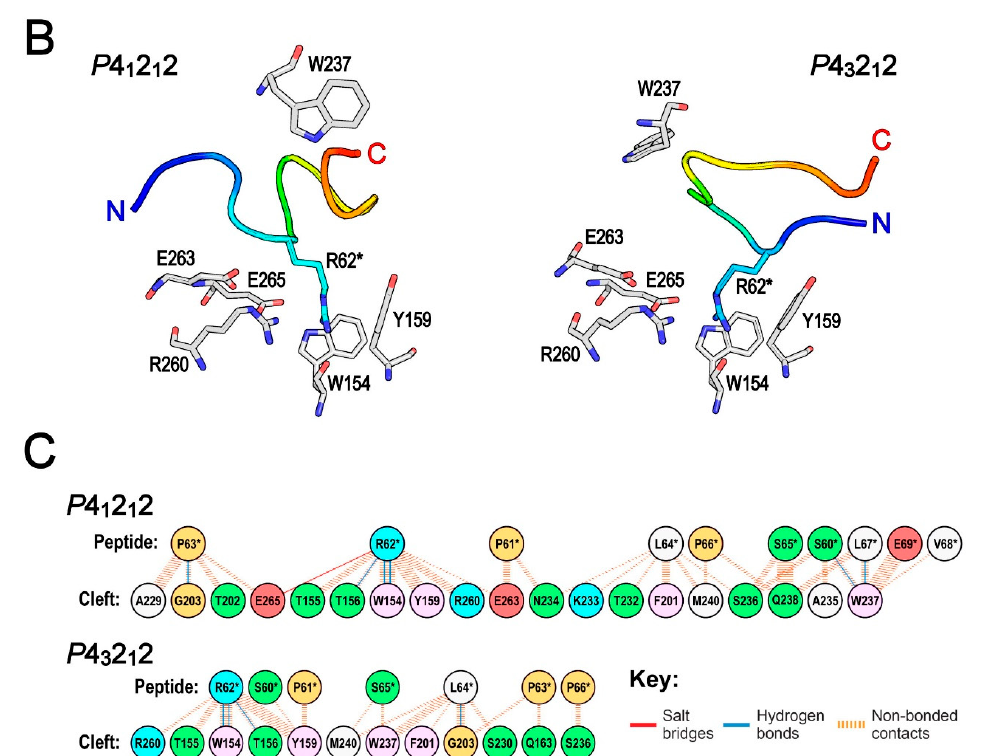
Figure 3. Two observed Arg peptide-binding modes of XopAI. ( A ) XopAI interaction found in the P 4 1 2 1 2 and P 4 3 2 1 2 crystals. The two interacting monomers are shown as ribbon models, and monomers A and B are colored in green and cyan, respectively. The bound N-terminal Arg peptide from monomer B is depicted as a red stick model. The insets show a zoomed-in view of the bound Arg (R62*). The carbon atoms of the bound Arg peptide are colored in pink; oxygen and nitrogen atoms are colored in red and blue, respectively. The black wire mesh depicts a F o – F c electron density (contoured at 3 σ level) of R62*. The residues involved in R62* recognition are represented as stick models and labeled. Yellow dotted lines show potential hydrogen bonds or salt bridges. ( B ) The comparison of Arg peptide-binding modes found in the P 4 1 2 1 2 and P 4 3 2 1 2 crystals. For clarity, the bound Arg peptide is shown as a C α trace and colored in the rainbow scheme; R62* is highlighted as a cyan stick model. W237 on the phosphate-nicotinamide (PN) loop and the residues involved in R62* binding are represented as gray stick models and labeled. ( C ) Residue interactions across the protein–peptide interface. The residues are colored to reflect their chemical properties (positive charged, cyan; negative charged, red; hydrophilic, green; aliphatic, white; aromatic, pink; proline or glycine, light orange). The number of cyan solid lines between any two residues indicates the number of potential hydrogen bonds between them. For non-bonded contacts, the width of the orange striped line is proportional to the number of atomic contacts between the two